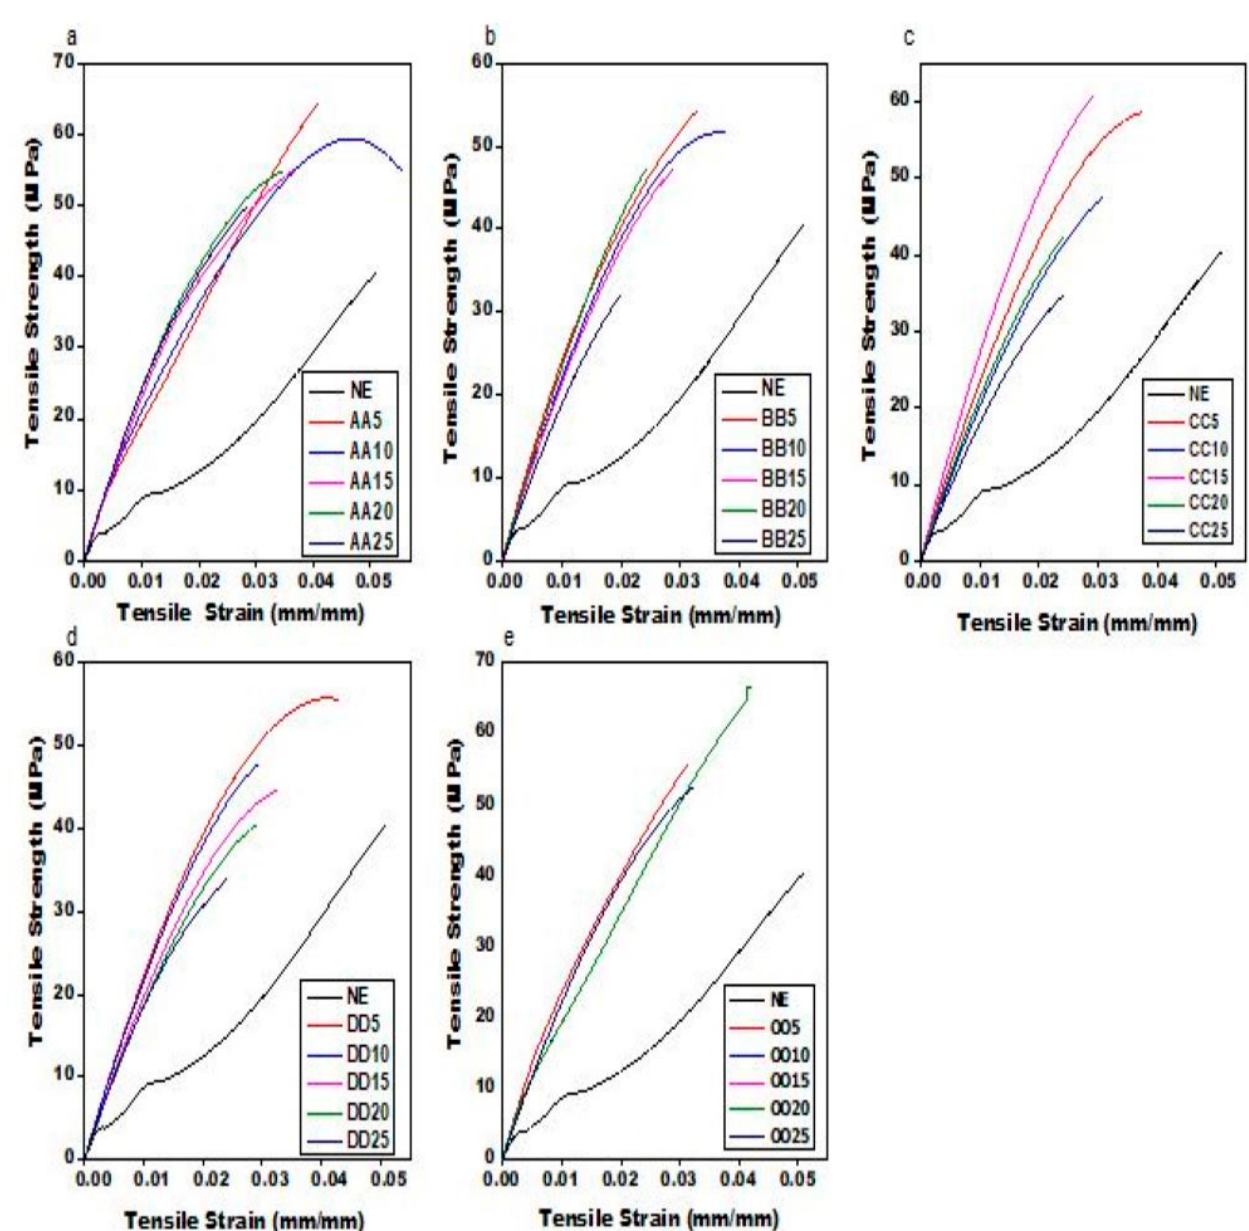
Figure 6. Graphical representation of tensile stress and strain for the comparison between ( a ) NE and AA5, AA10, AA15, AA20, and AA25; ( b ) NE and BB5, BB10, BB15, BB20, and BB25; ( c ) NE and CC5, CC10, CC15, CC20, and CC25; ( d ) NE and DD5, DD10, DD15, DD20, and DD25; and ( e ) NE and OO5, OO10, OO15, OO20, and OO25.